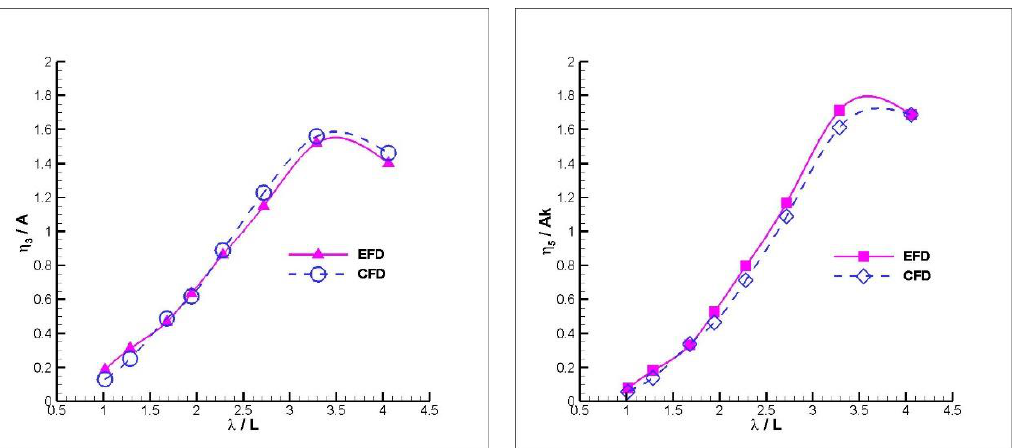
Figure 11. Heave ( left ) and Pitch ( right ) RAOs of the warped hull at Fn B = 2.82.